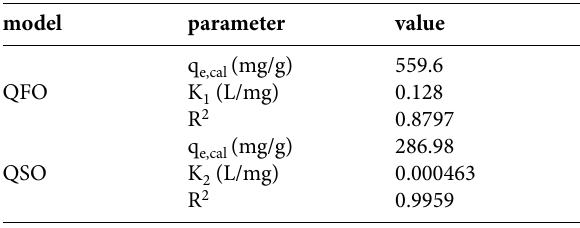
Table 4. Constants and parameters of the QFO and QSO kinetic models for the sorption of sodium ion from aqueous solution using